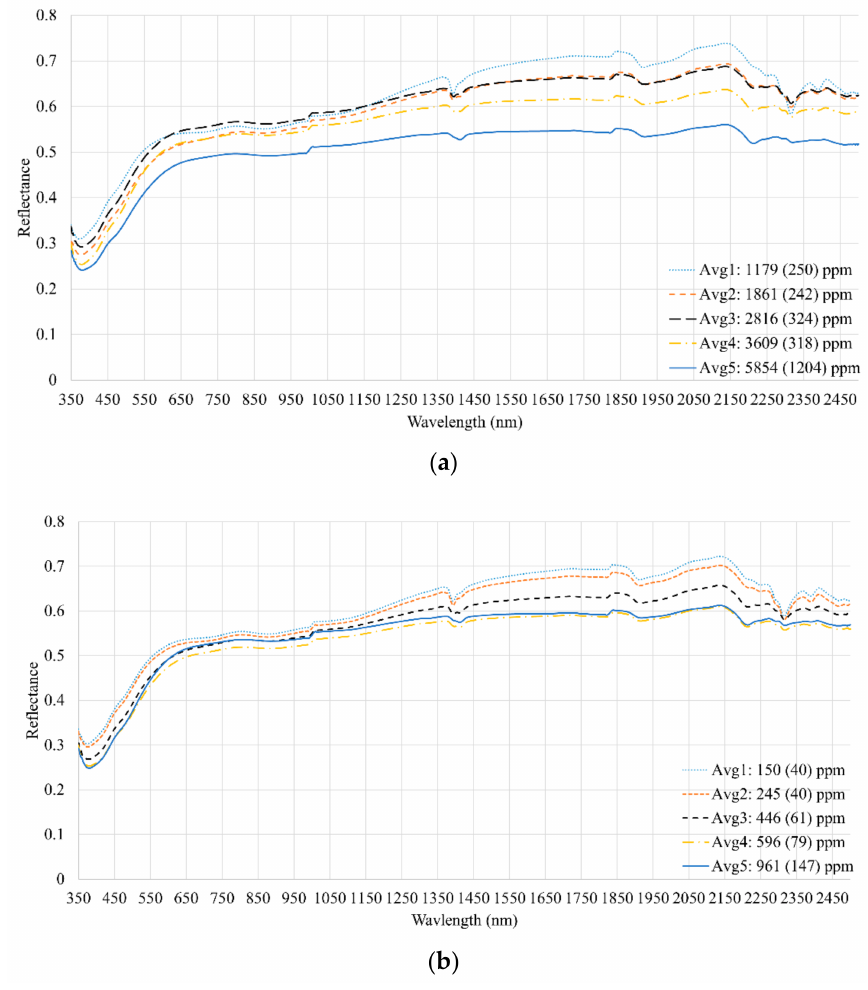
Figure 4. Stacked averaged raw reflectance sample spectra divided into 5 level-concentrations with standard deviation (in the parentheses): ( a ) As concentration; ( b ) Pb